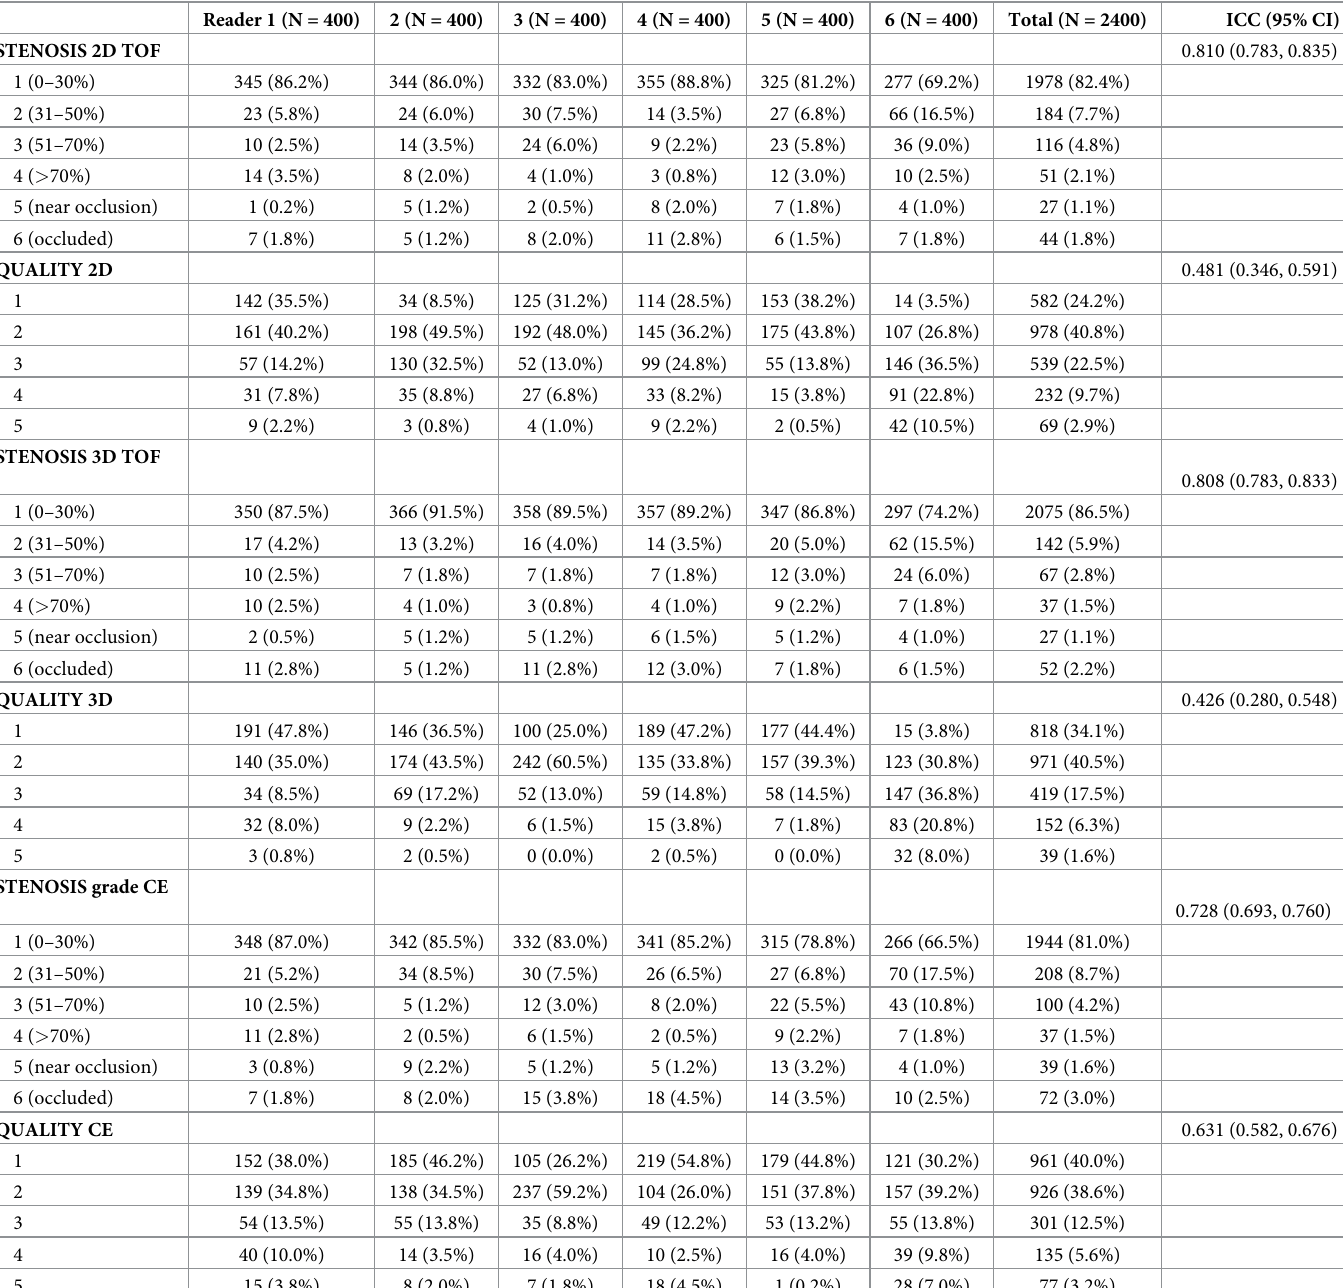
Table 1. Inter-rater